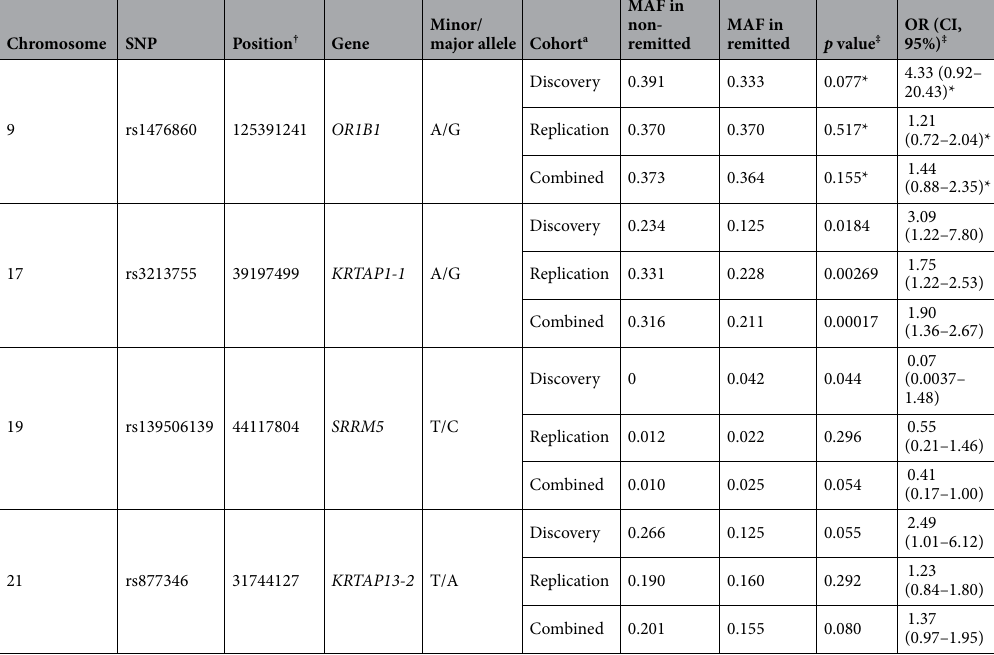
Table 2. Candidate loss-of-function variants associated with remission following SSRI treatment in patients with MDD (discovery set, n = 100; replication set, n = 553). MAF minor allele frequency, OR odds ratio, CI confidence interval, SNP single nucleotide polymorphism, NA not available. † Physical position based on human reference genome build hg 19 (GRCh37). ‡ p value and OR were calculated using a dominant disease model. The dominant allele is a test for the minor allele. * p value was calculated using a recessive disease model. a In the discovery set, remitted, n = 36; non-remitted, n = 64; in the replication set, remitted, n = 185; non-remitted, n =